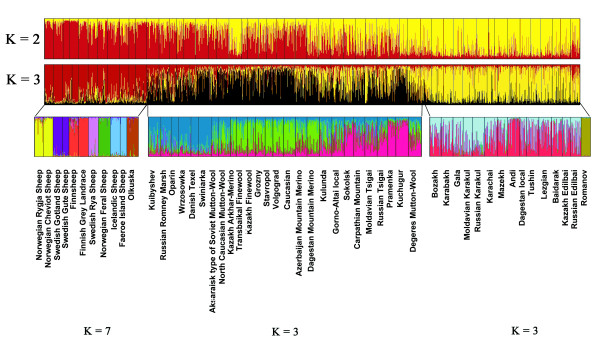
Clustering of 52 sheep breeds. Individuals are presented as vertical lines divided into K colors, representing constructed populations. The lowest row represents further clustering of 3 groups, identified at K = 3, separately. The Nordic group is divided into 7 subclusters, while the Composite (in the middle) and the Fat-tailed groups each split into 3 subclusters.